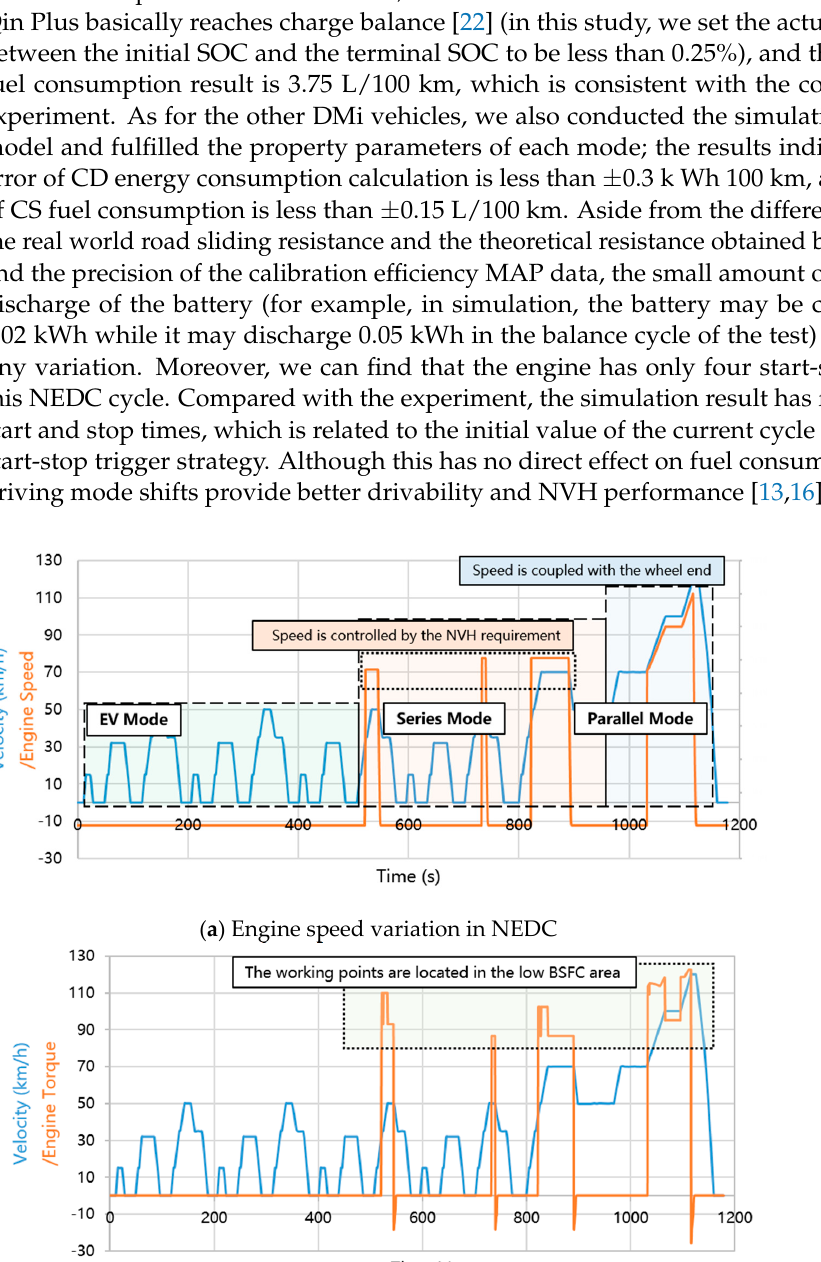
( c ) SOC variation in NEDC Figure 6. Qin Plus charge sustaining process simulation. Figure 7 shows the systematic decomposition of the fuel consumption performance of Qin Plus. Aerodynamic drag, rolling resistance, and powertrain efficiency are the highest en- ergy consumption factors in addition to engine heat loss. As specified in the part of the re- sistance decomposition, the rolling resistance and efficiency of the powertrain have been greatly optimized. The potential optimization of the resistance and the energy consumption lies in aerodynamic drag reduction. We conduct the statistical analysis of thermal efficiency distribution to judge whether the high-efficiency area of the 1.5 L engine is fully utilized. It can be seen from the right half of Figure 7 that close to 10% of the operating points fall in the most efficient region with a thermal efficiency range from 39% to 41%, and the thermal efficiency of